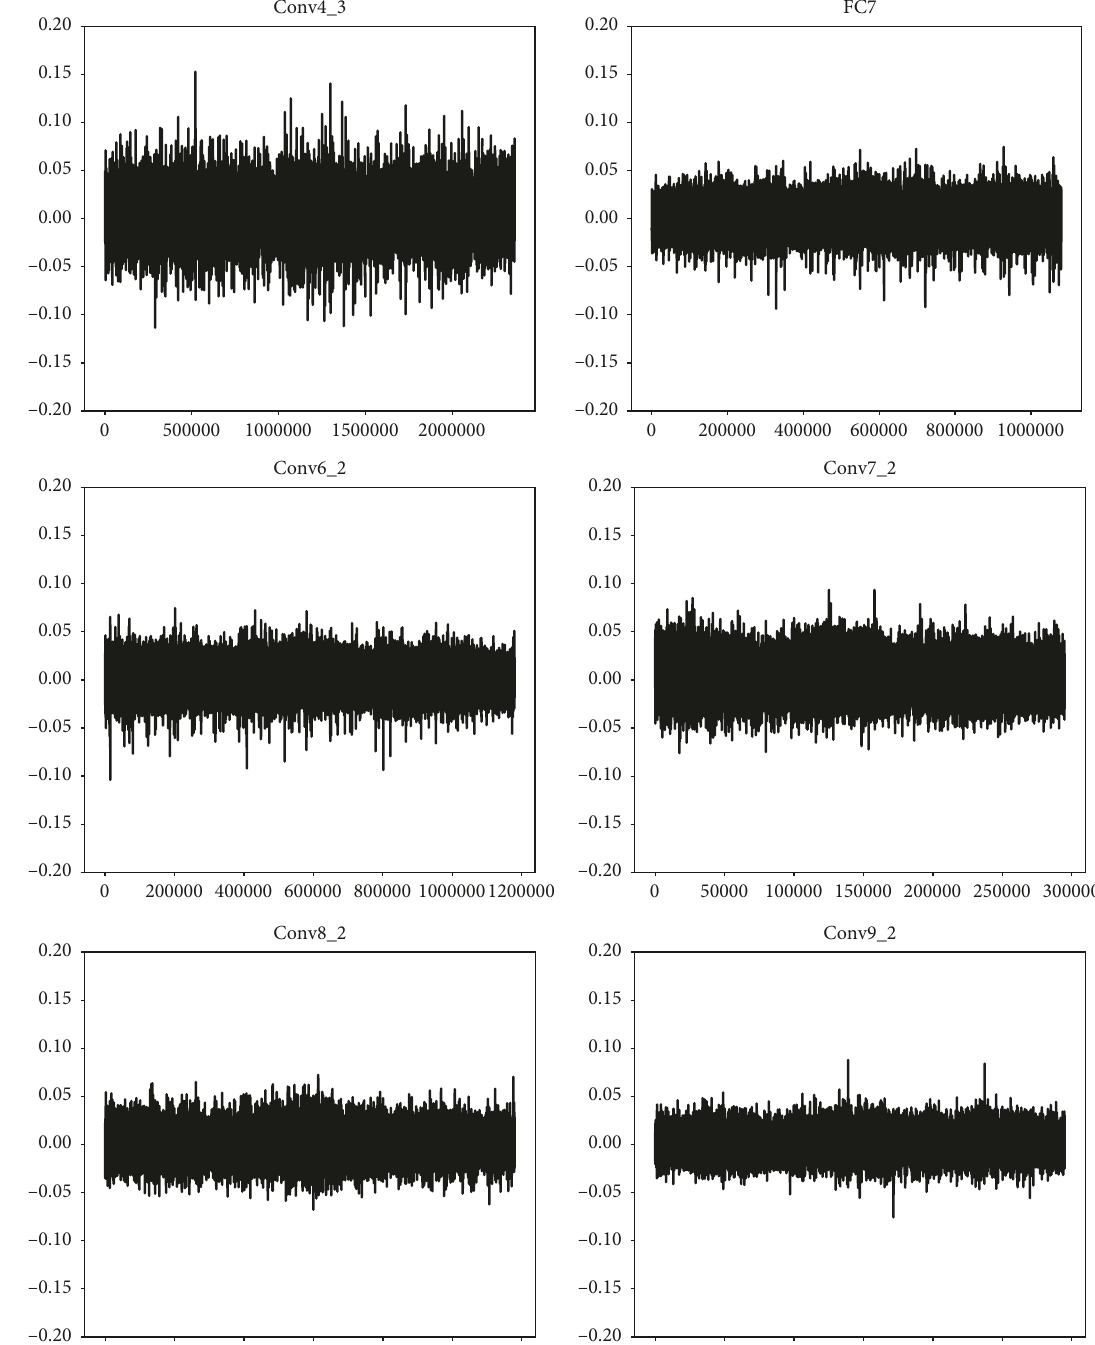
Figure 2: Visualization of feature layer